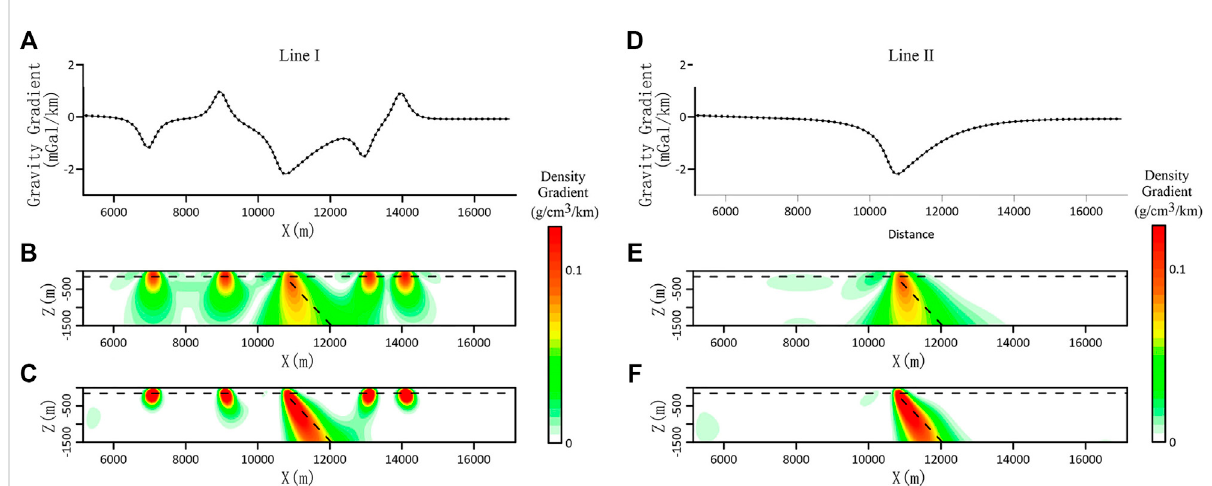
FIGURE 5 Horizontal gravitygradientcurveanddensitygradientinversionresultpro fi leinthex-directionoflineIandlineII. (A) Horizontal gravitygradient anomalycurveoflineI. (B) SlicetheinversionresultoflineIwithoutfocusingconstraint. (C) LineIfocusinginversionresultslice. (D) Horizontalgravity gradient anomaly curve of line II. (E) Slice the inversion result of line II without focusing constraint. (F) Slicing of line II focusing inversion